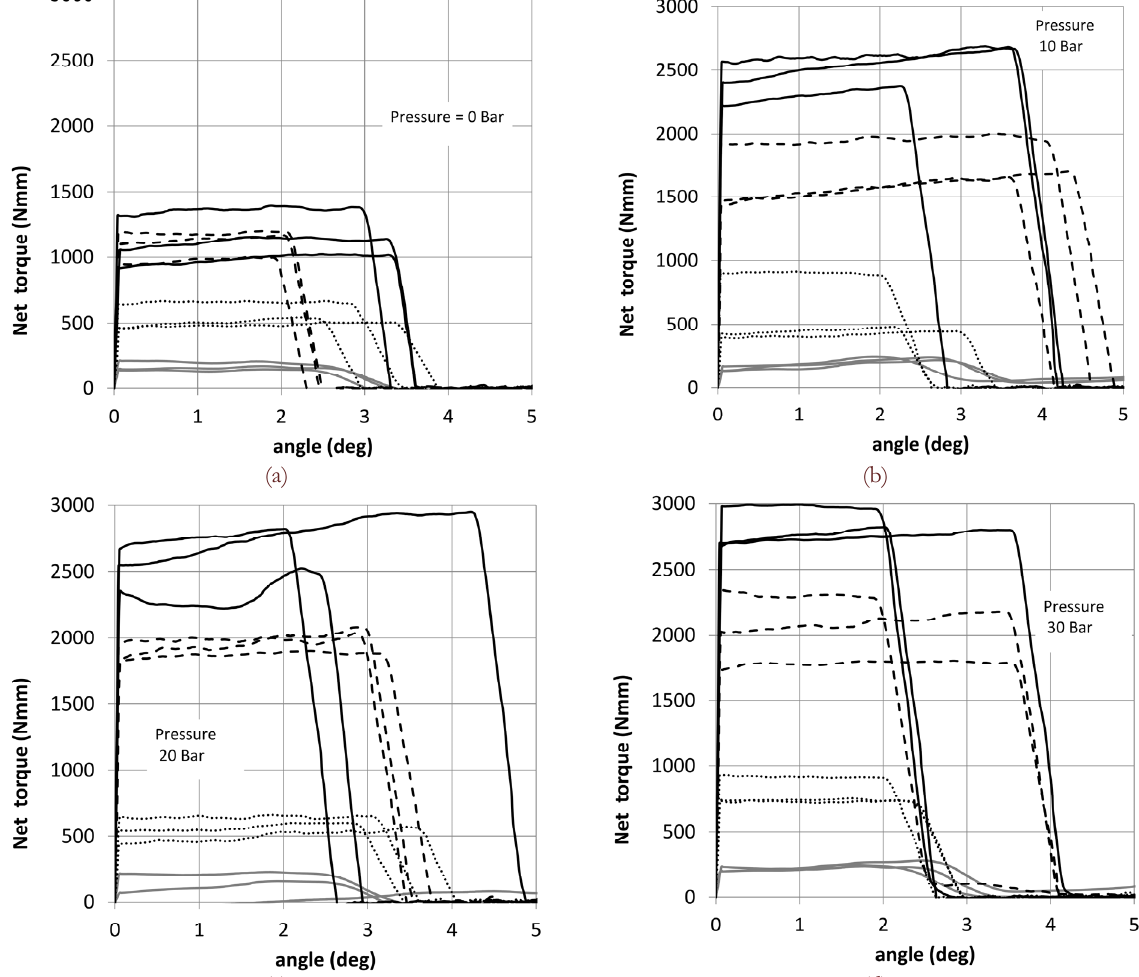
Figure 6: Experimental torque-angle curves for 50mT (grey solid lines), 100mT (dotted lines), 200mT (dashed line) and 300mT (solid black line). Pressures of 0,10,20 and 30 Bars, reported in (a), (b), (c) and (d), respectively.